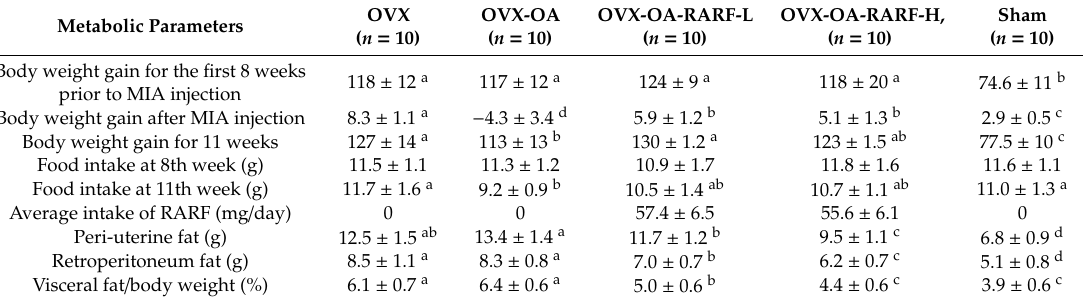
Table 3. Metabolic parameters at the end of experimental periods.